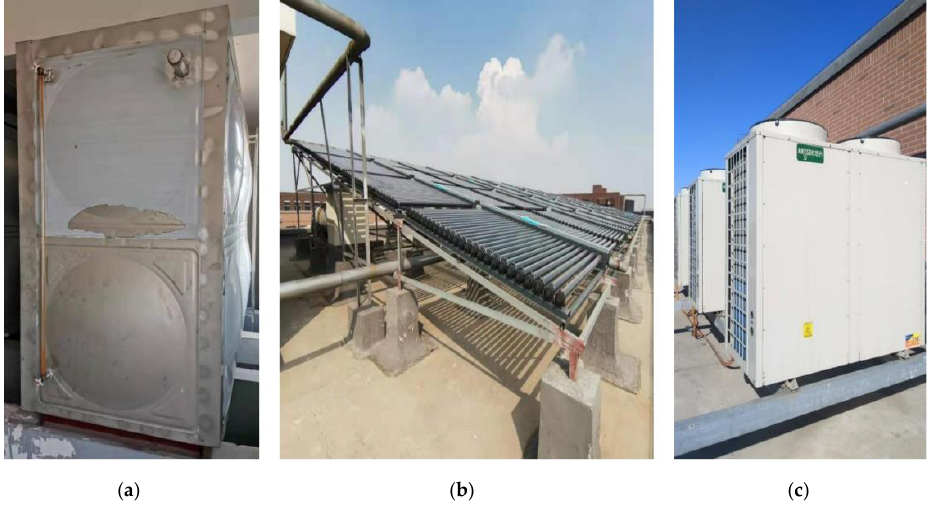
Figure 3. Main equipment of the system. ( a ) Water tank; ( b ) Solar collector; ( c ) Air source heat pump unit.